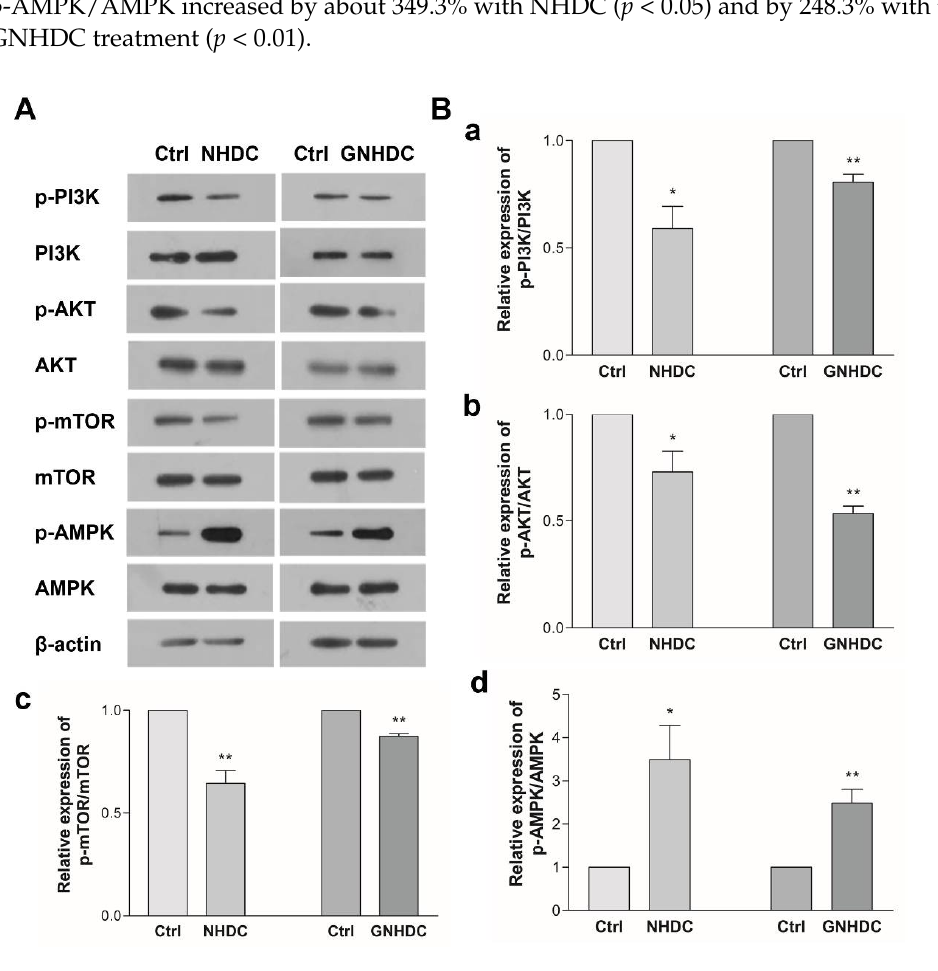
Figure 6. Effects of NHDC and GNHDC on the PI3K/AKT/mTOR pathway and AMPK in 3T3-L1 cells. The expression of protein was analyzed for the PI3K/AKT/mTOR pathway and AMPK. ( A ) Representative blots are presented; ( B ) Quantification of expression of ( a ) p-PI3K/PI3K, ( b ) p- AKT/AKT, ( c ) p-mTOR/mTOR, and ( d ) p-AMPK/AMPK. All data are shown as the mean ± SEM and were analyzed by an unpaired Student’s t -test ( n = 3). Each asterisk indicates significant difference as compared to Ctrl; * ( p < 0.05) and ** ( p < 0.01). AKT, protein kinase B; AMPK, AMP-activated protein kinase; mTOR, mammalian target of rapamycin; PI3K, phosphoinositide 3 kinase; p-AKT, phospho-protein kinase B; p-AMPK, phospho-AMP-activated protein kinase; p-mTOR, phospho- mammalian target of rapamycin; p-PI3K, phospho-phosphoinositide 3 kinase; Ctrl, control; NHDC, neohesperidin dihydrochalcone; GNHDC,